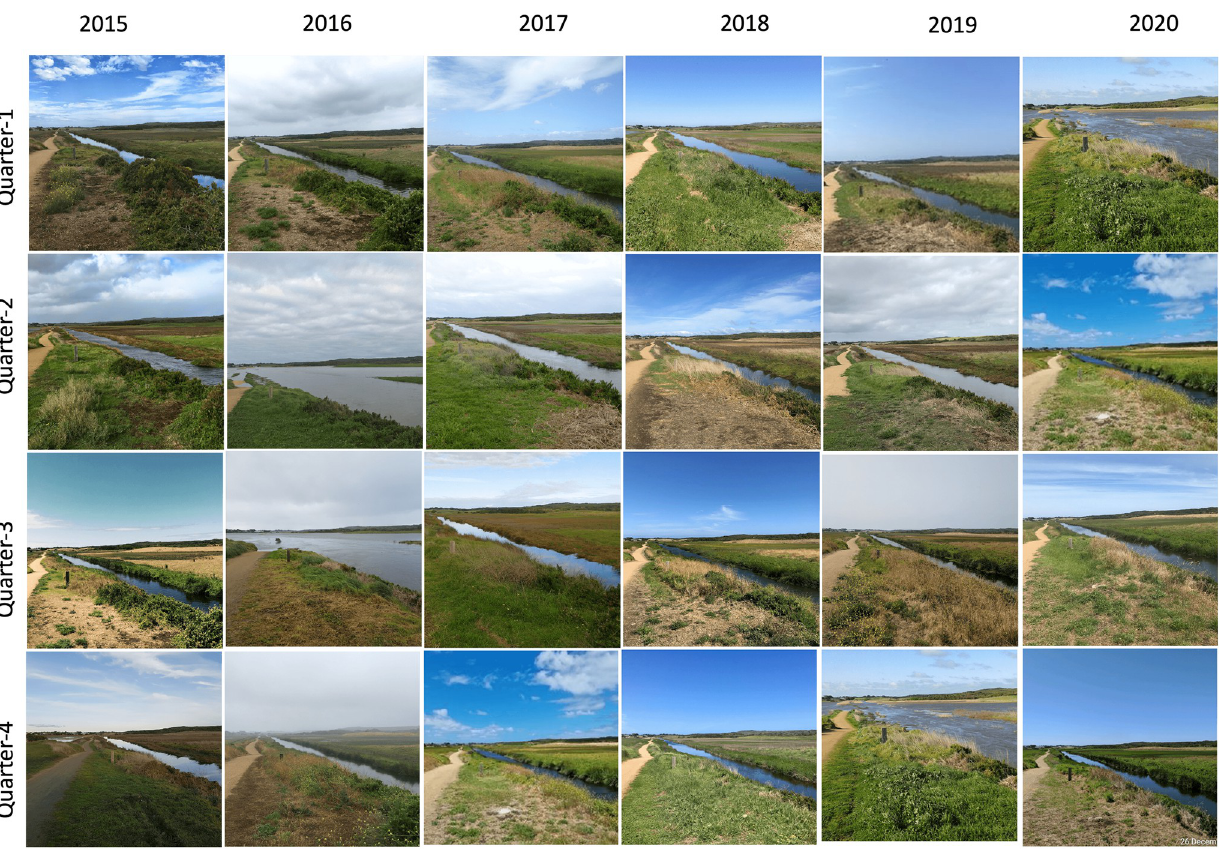
Fig 3. Sample images of the Warrnambool region site, one of the Fluker post points of collection, taken quarterly over several years between 2015 and 2020.